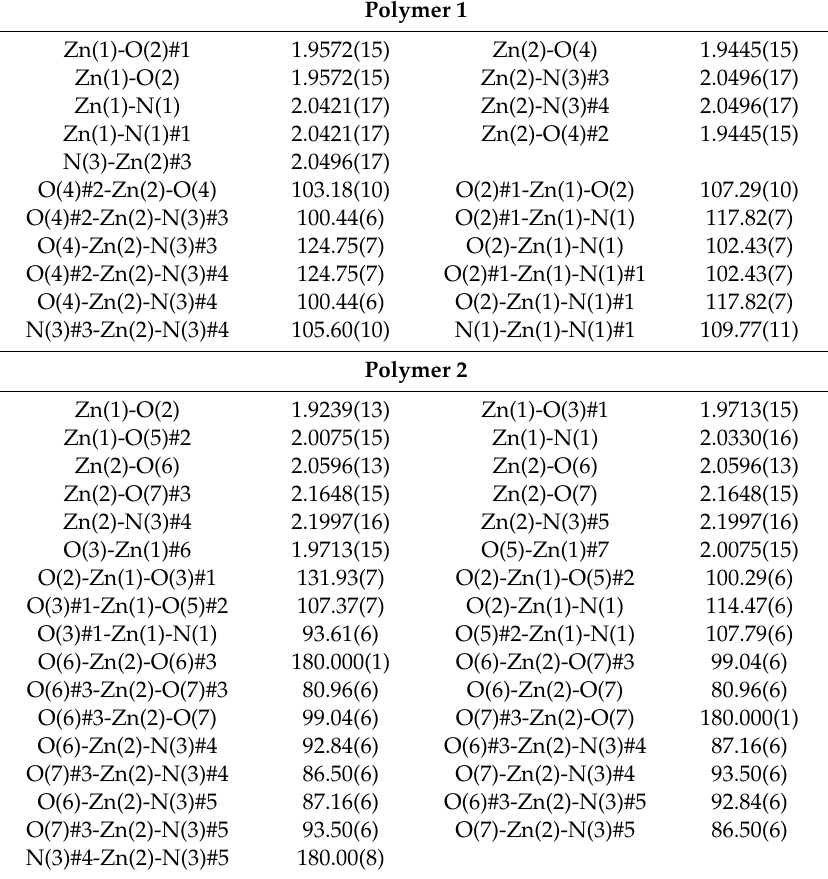
Table 2. Selected bonds (Å) and angles ( ◦ ) for Polymers 1–3. Polymer